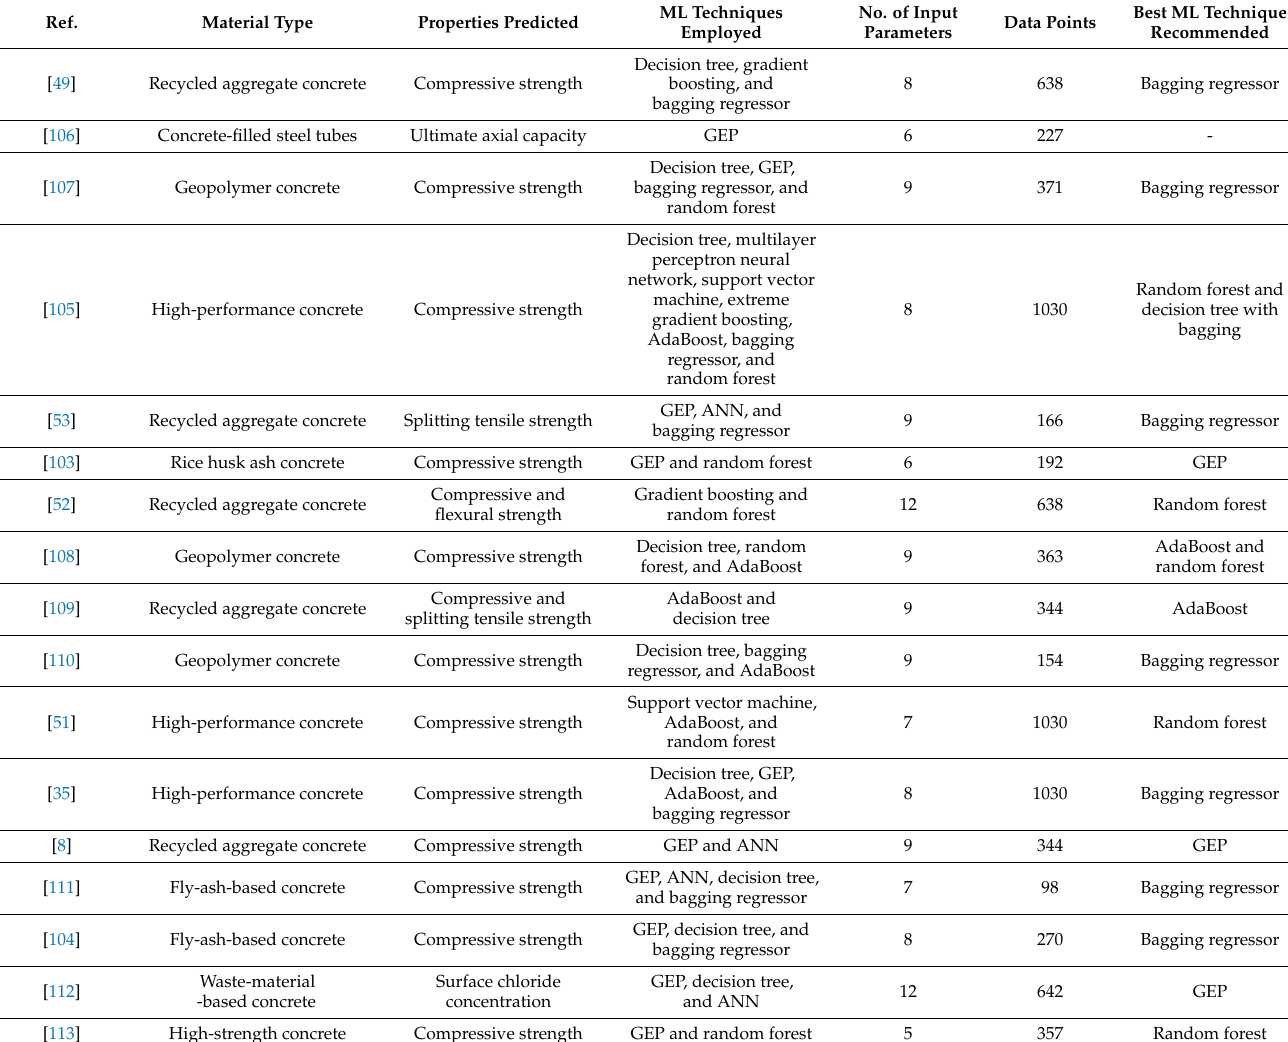
Table 6. Types of machine learning techniques used in previous studies.